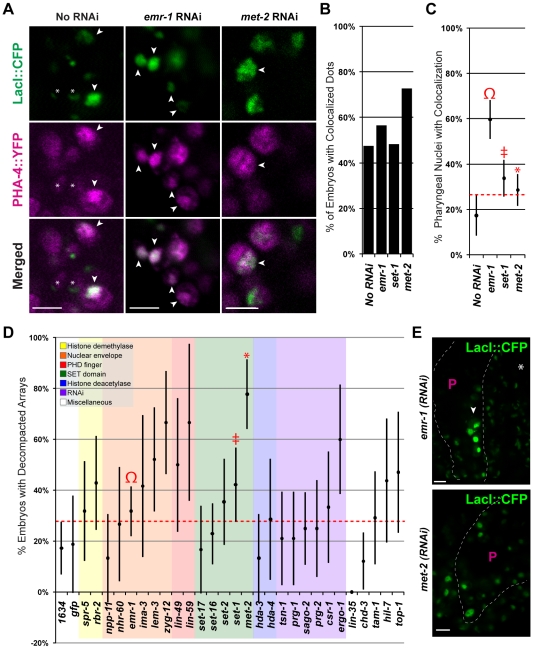
Emerin inhibits PHA-4 binding in the pharynx.(A) CFP::LacI (depicted in green) and PHA-4::YFP (depicted in magenta) co-localization on pseudo-chromosomes bearing pax-1MutA after No RNAi, emr-1(RNAi) or met-2(RNAi). (B) Percentage of embryos with at least one co-localized dot (No RNAi 9/19, emr-1(RNAi) 13/23, set-1(RNAi) 14/29, and met-2(RNAi) 16/22) (C) Percentage of pharyngeal nuclei with bound PHA-4::YFP among embryos with co-localization. After emr-1 reduction (Ω, n = 13), embryos had a ∼3 fold increase in PHA-4::YFP binding compared to No RNAi controls (n = 9). For met-2 and set-1 n = 16 and 14, respectively D) The proportion of embryos bearing de-condensed arrays for each RNAi treatment is graphed. See Table S2 for the number of embryos assayed. (E). Example of pseudo-chromosomes after emr-1(RNAi) or met-2(RNAi). Decompaction within the pharynx (arrowhead) presumably reflects PHA-4 association. Scale bar, 3 microns.